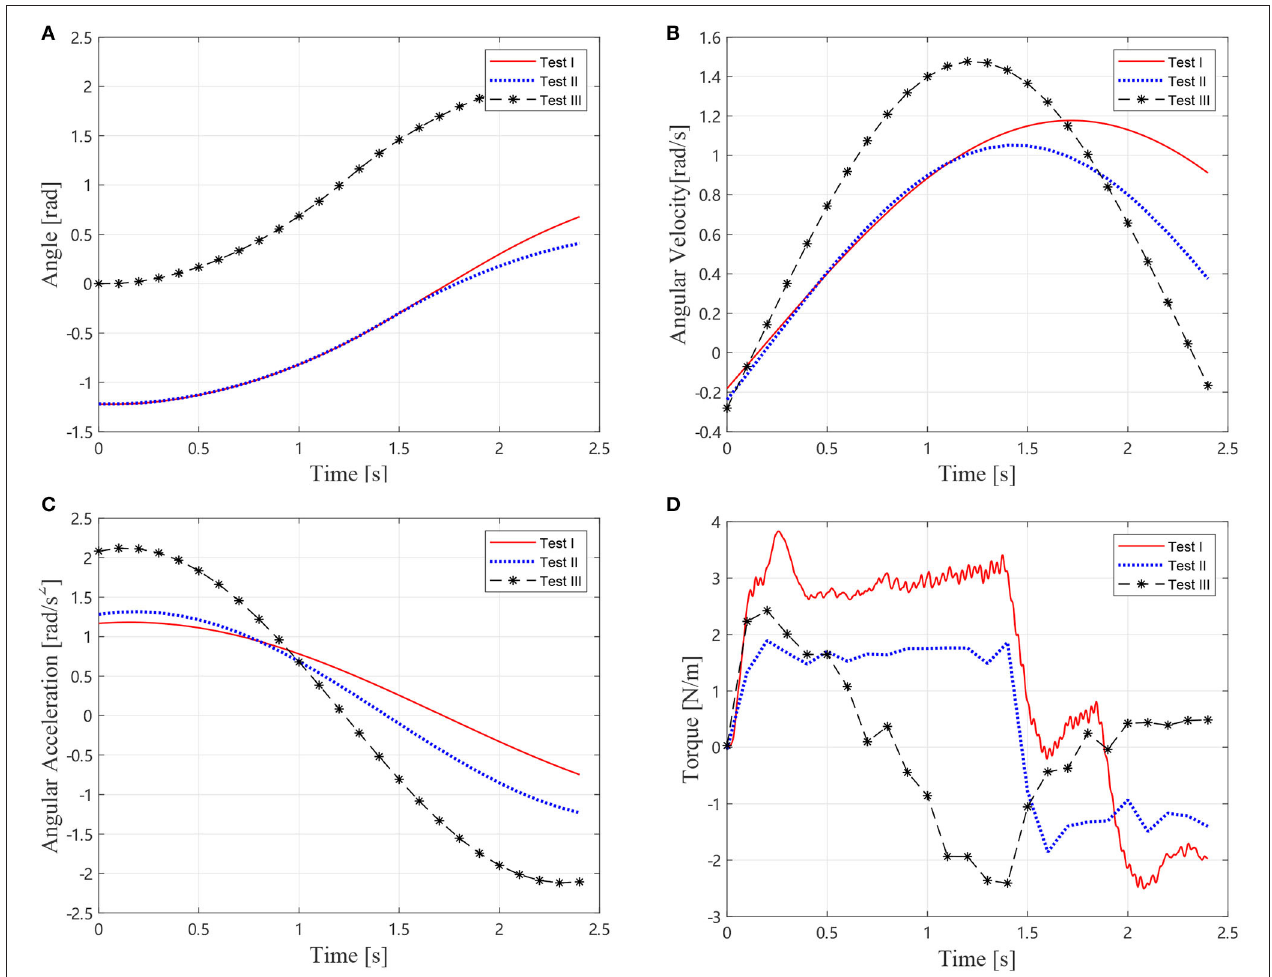
FIGURE 9 | Motions and torque of the experimental Test I, II, and III, (A) Joint angles, (B) Joint angular velocties, (C) Joint angular accelerations, and (D) Joint